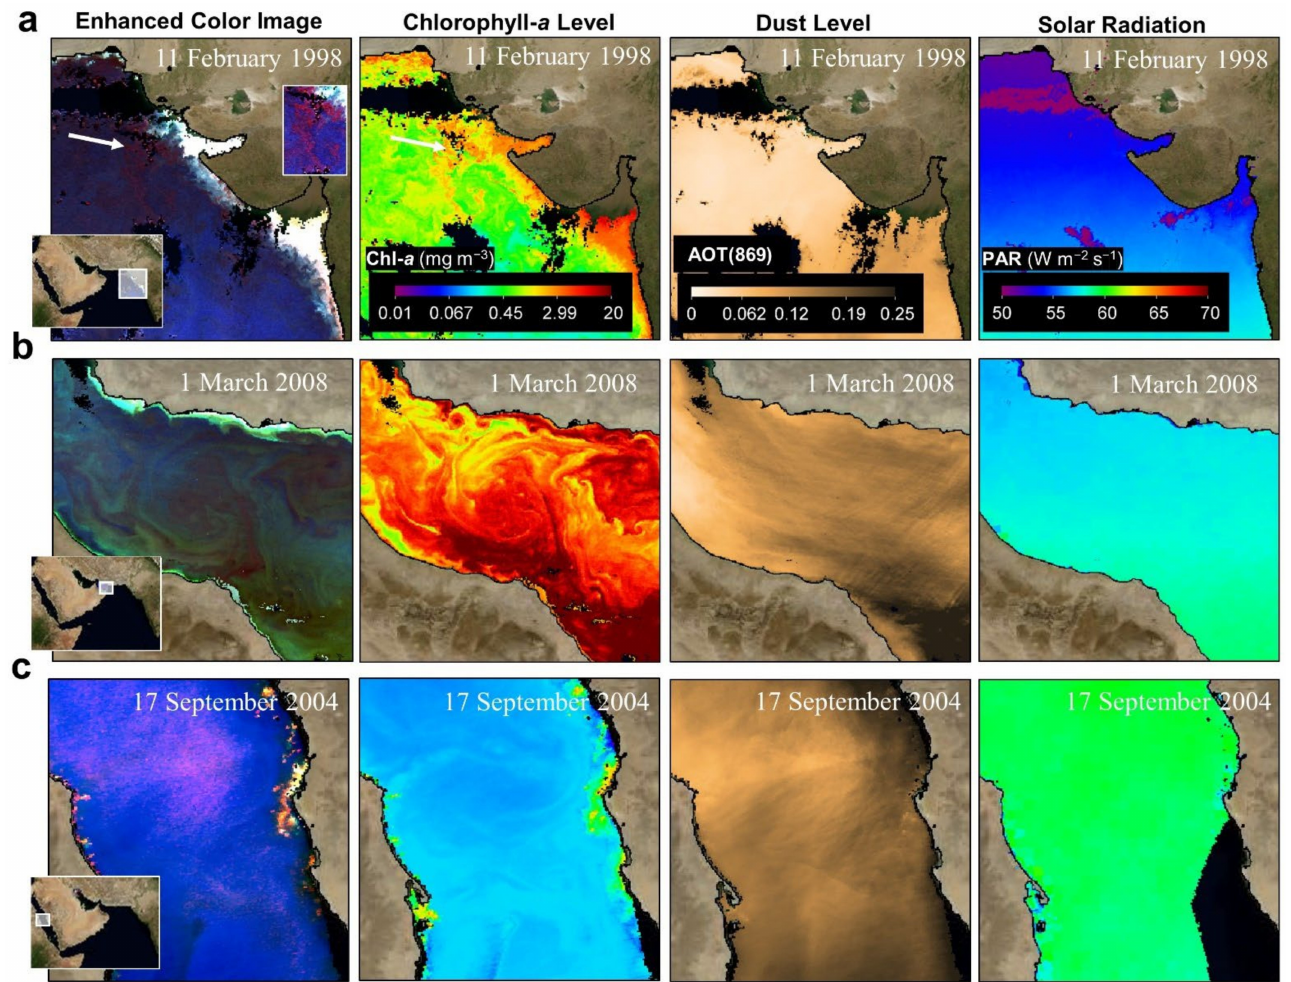
Figure 8. Enhanced color image (ERGB), Chl- a , AOT, and PAR derived from satellite images during Trichodesmium bloom events in the Arabian Sea, Sea of Oman, and the Red Sea during: ( a ) 11 February 1998, ( b ) 1 March 2008, and ( c ) 17 September 2004. The first column in the figure shows the ERGB images of three different regions where algal blooms occurred, retrieved from SeaWiFS, Terra, and Aqua, respectively. These images indicate the presence of the blooms. The second column shows the Chl- a concentrations. Red color indicates high concentrations of Chl- a . The third column shows AOT maps during the aforementioned bloom events in which darker brown color indicates high level of dust aerosols (AOT). The last column represents the PAR maps that can indicate the PAR level during the algal bloom events, in which high PAR is shown by the red